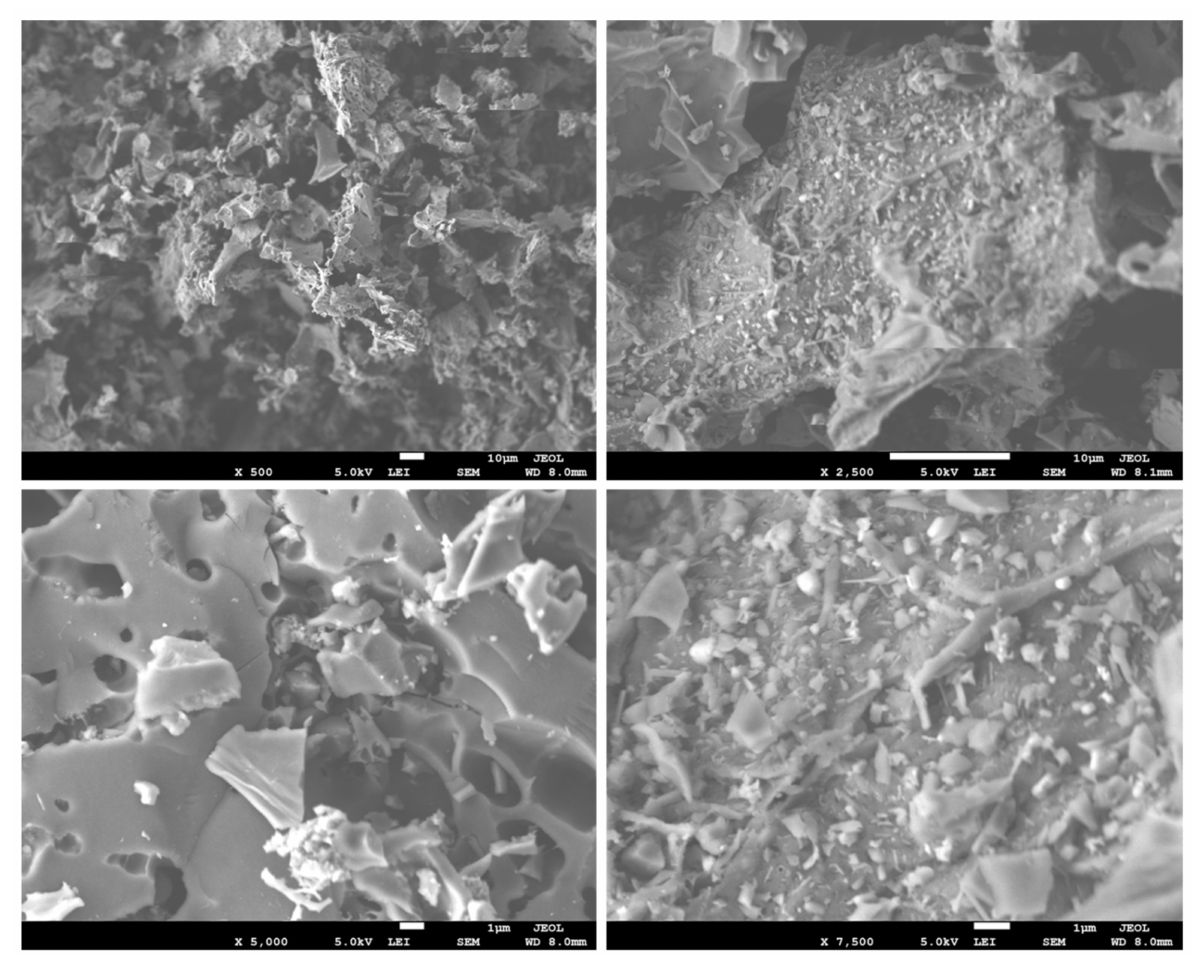
Figure 5. SEM micrographs of the walnut shell biochar.